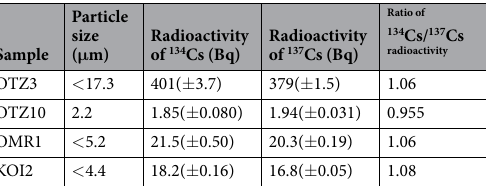
Table 1. Radioactivity of four CsMPs described in the present study. The radioactivity was decay-corrected to March 12, 2011, 15:36 JST. The uncertainties in the radioactivity analyses are given in the parenthesis. The particle size was measured using the SEM